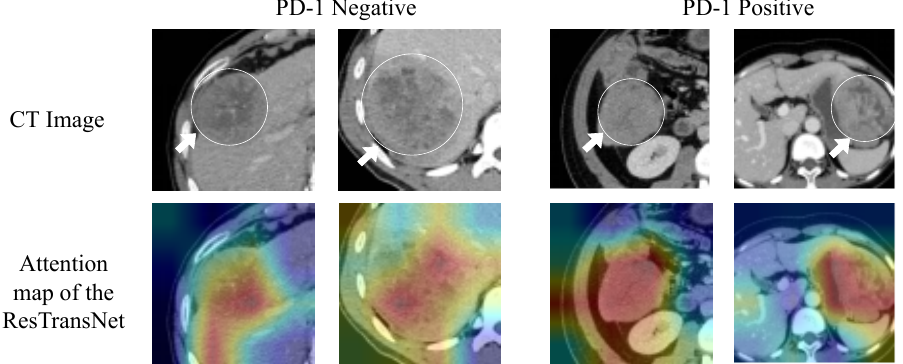
Figure 5. Visualization of the feature maps learned from the convolution and transformer layers. These features come from the convolution filters of the 6th and 27th layers and the last transformer layer. Each convolutional layer includes hundreds of filters, and only the first four filters are illustrated in each layer.